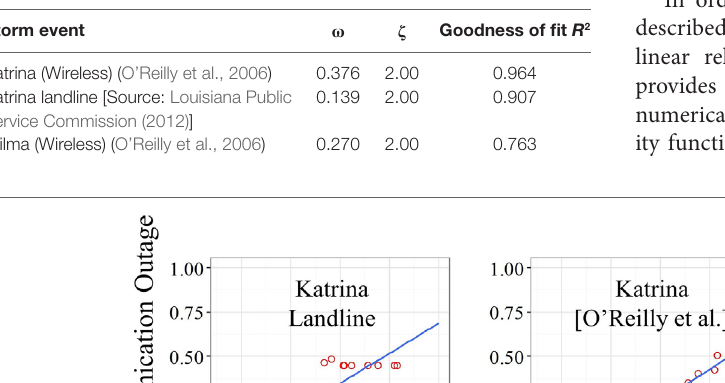
TaBle 6 | Inoperability results for telecommunications outage